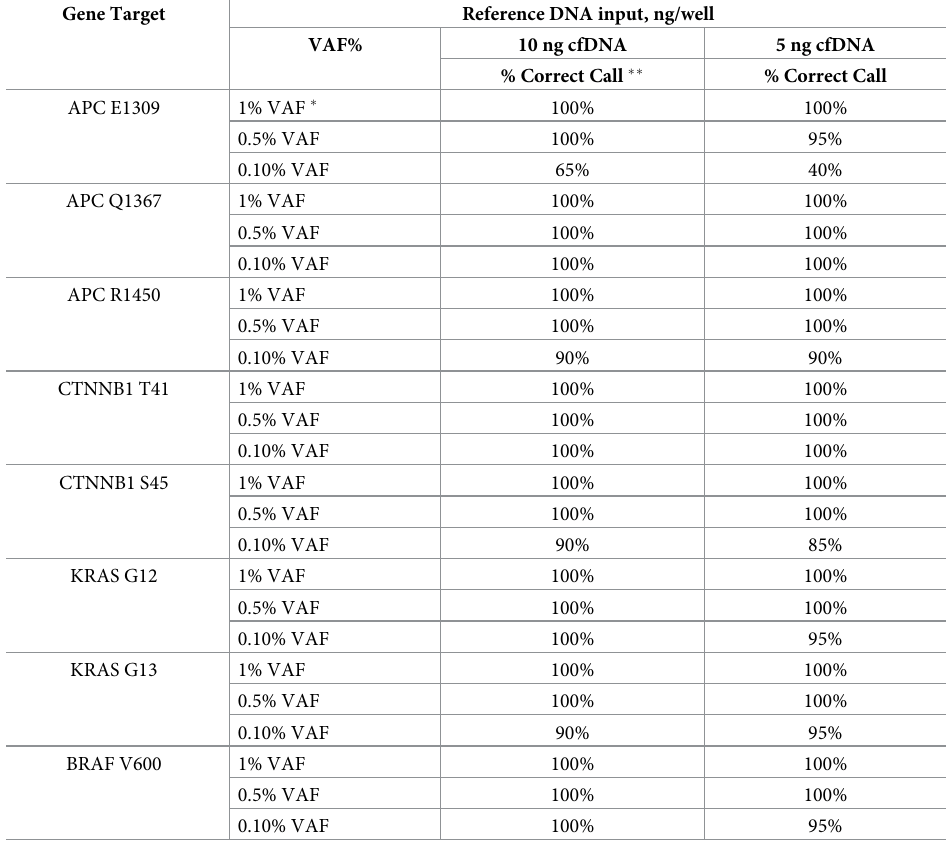
Table 2. Summary of assay limit of detection for the cfDNA